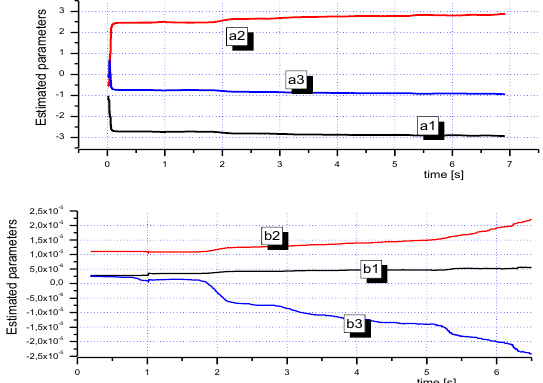
Fig. 3. Time courses of the model parameters of the control object determined using WRLS